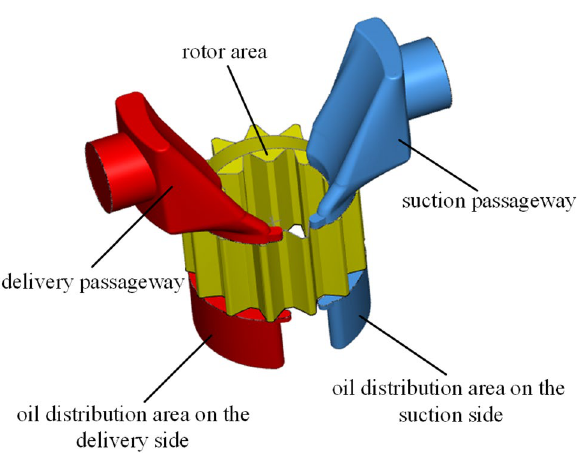
Figure 9. Internal fluid domain of Truninger